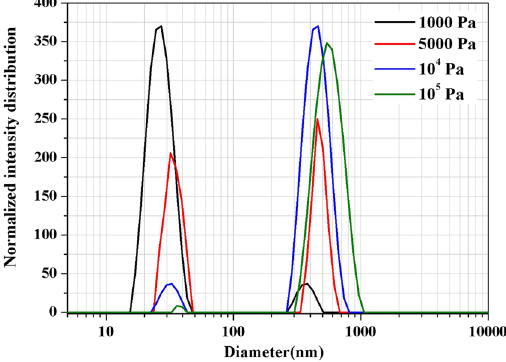
Figure 8. Size distributions of GeAs ultrafine particles under different